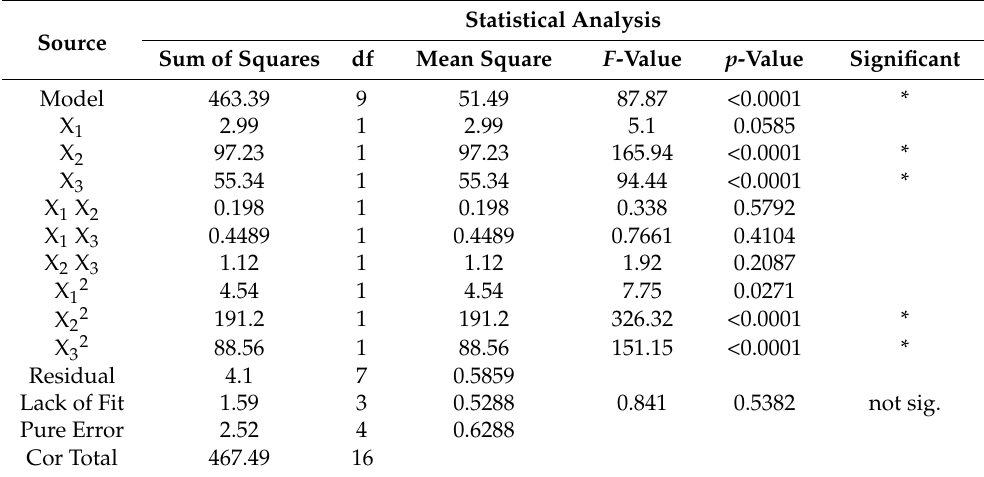
Table 5. Variance analysis (ANOVA) for the maximum thinning rate of the stamping sheet.